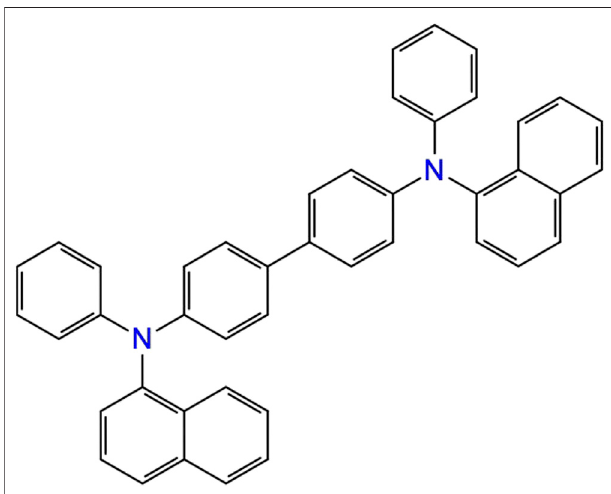
FIGURE 2 | Chemical structure of NBP, which is used as a reference for the oxidation potential.